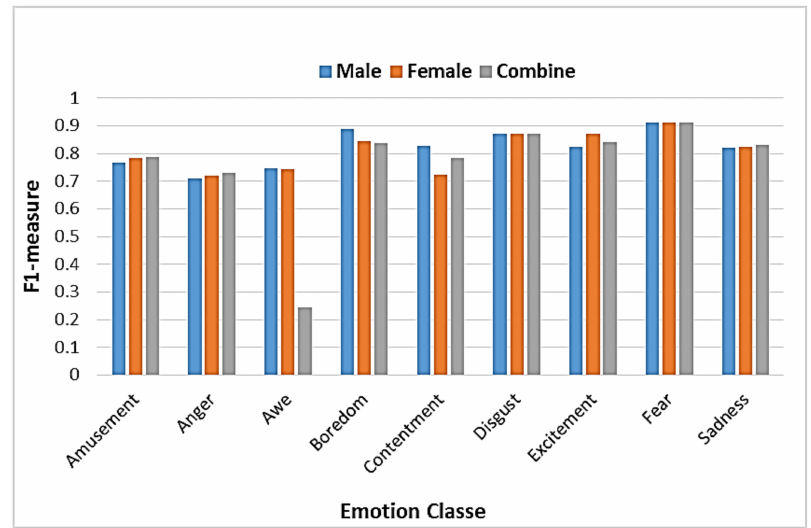
Figure 5. Best-case average F1-score for inferring emotion tags at top-level with nine di ff erent emotions using K-NN.